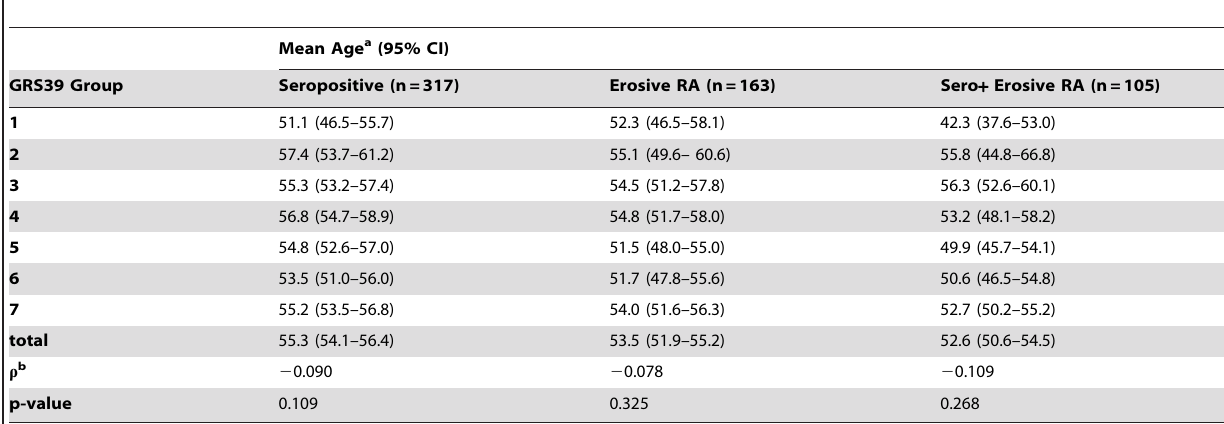
Table 3. Relationship between weighted GRS as groups and as continuous and age at RA symptom start.